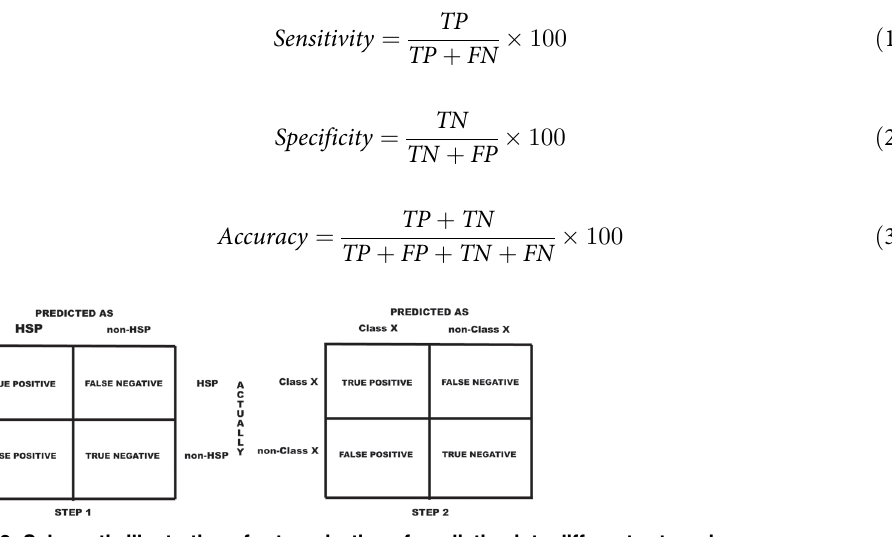
Fig 2. Schematic illustration of categorization of prediction into different